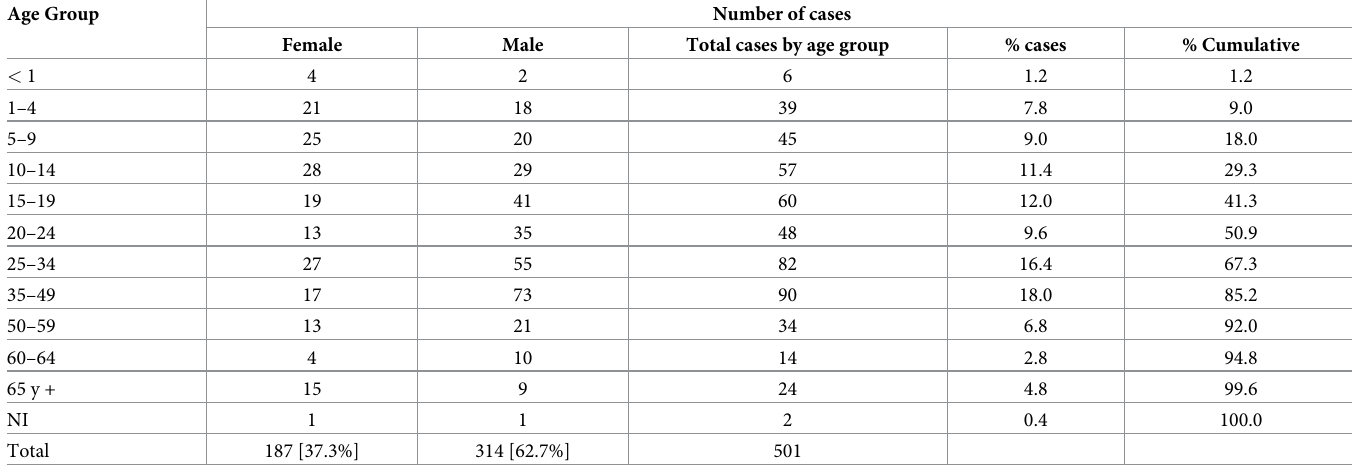
Table 4. Distribution of malaria cases by age group and sex in Darie´n region, Panama.